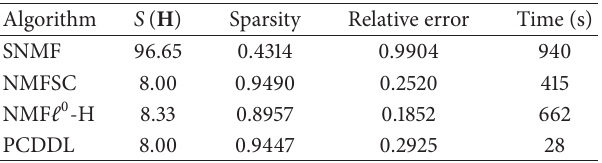
Table 2: Comparisons of 𝑆 ( H )-based sparsity, Hoyer’s sparsity